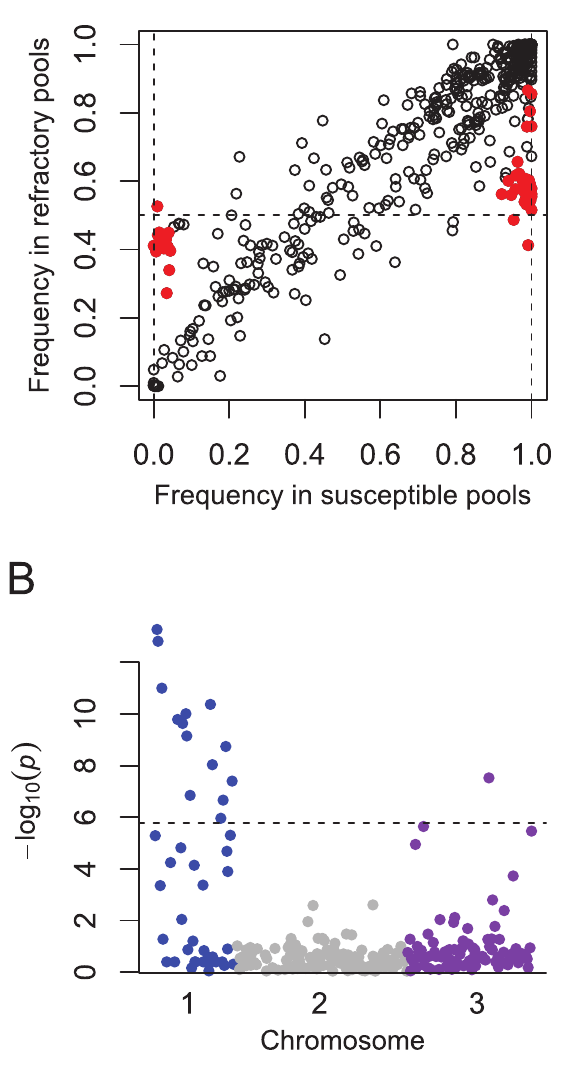
Figure 6. Resistance to B.malayi is determined by a single locus that is dominant in action and maps to the first chromosome. A) Average frequencies of the reference allele (the SNP allele in the published genome) in the pools of refractory versus susceptible mosquitoes. A cluster of markers with , 100% frequency in susceptible pools (vertical dotted lines) and , 50% frequency in refractory pools (horizontal dotted line) is consistent with resistance being determined by a single locus that is dominant in action. Red points indicate statistically significant differences in allele frequencies between refractory and susceptible pools at a genome-wide significance of P , 0.01. B) Manhattan plot of the minimum P -values for each scaffold, with the x-axis representing a physical map created from the linkage map. Only markers from contigs used to assemble the linkage map are shown here (see Table S2). Dotted line indicates significance at